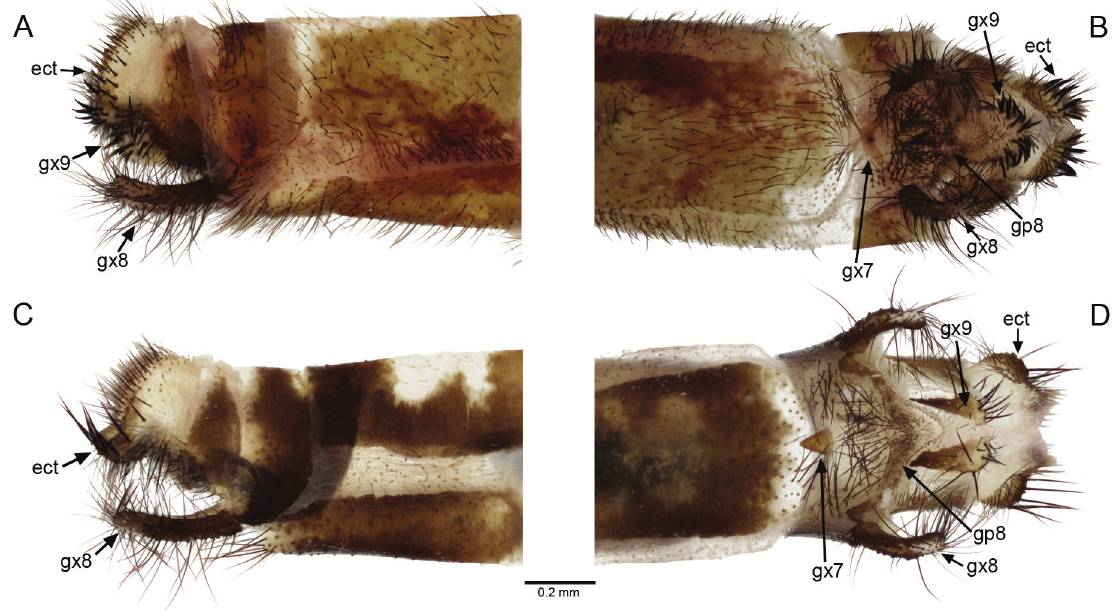
Figure 9. Female genitalia of Gymnocnemia. A–B Gymnocnemia variegata [Greece, Corfu], A lateral view, B ventral view; C–D Gymnocnemia mirabilis [Oman, Jabal Shams], C lateral view, D ventral view. Abbreviations: ect – ectoproct, gp8 – gonapo- physis 8, gx7 – gonocoxites 7, gx8 – gonocoxite 8, gx9 – gonocoxite 9.